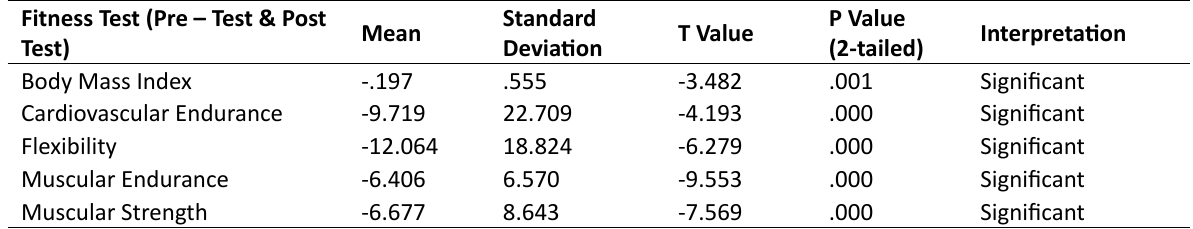
Table 6. Level of Significant Difference Fitness Test (Pre – Test &